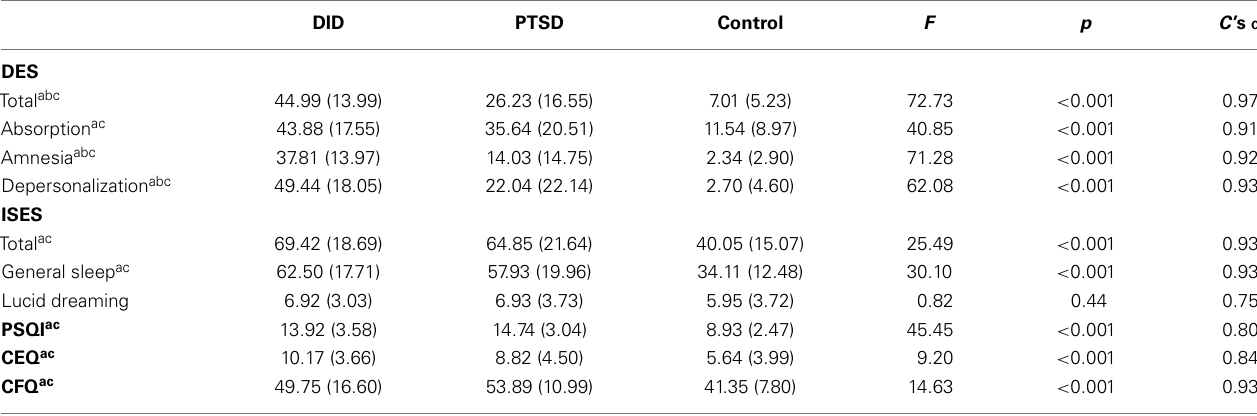
Table 1 | Mean scores (standard deviations) on dissociation (DES), unusual sleep experiences (ISES), sleep quality (PSQI), fantasy proneness (CEQ), and cognitive failures (CFQ) of the DID ( N = 12), PTSD ( N = 27), and control ( N = 55) groups . DID